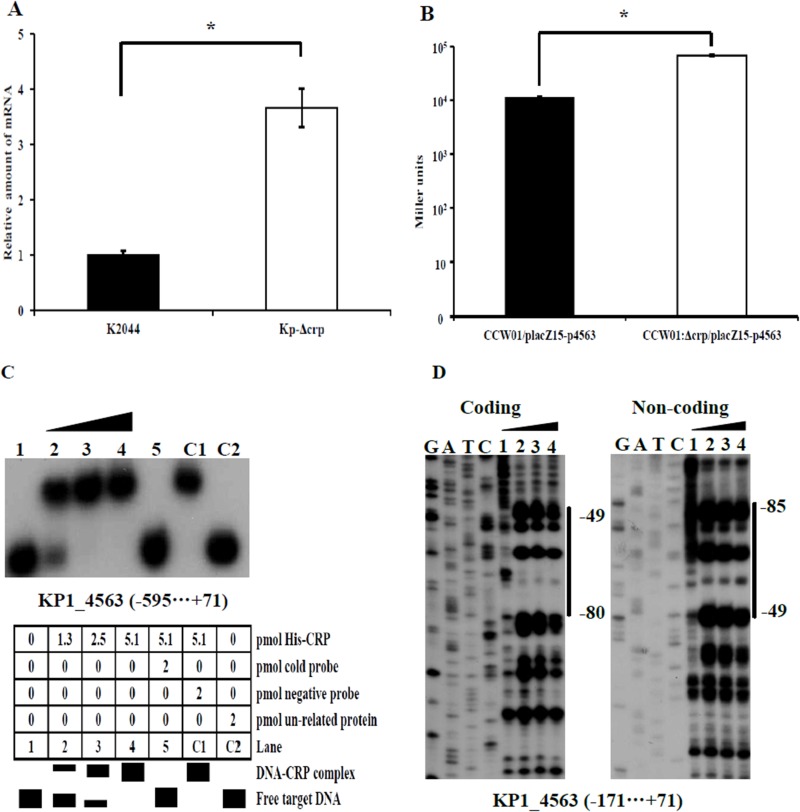
Transcriptional regulation of KP1_4563 by CRP.(A) Quantitative RT-PCR (qRT-PCR). Transcriptional expression of KP1_4563 in WT and Kp-Δcrp. The results are expressed as the percentage of WT expression. Data are presented as the mean of at least three technical replicates (mean ± standard deviation). Statistical significance was analyzed by independent samples t- test. Significant difference is indicated by * for P<0.05. (B) LacZ fusion assay. The putative promoter region of KP1_4563 was cloned into the lacZ transcriptional fusion placZ15 plasmid and then introduced into CCW01 or CCW01Δcrp to determine promoter activity. The results are expressed as β-galactosidase activity (Miller units) in the cellular extracts. Statistical significance was analyzed by independent samples t-test. Significant difference is indicated by * for P<0.05. (C) EMSA. The radioactively labeled putative promoter region of KP1_4563 was incubated with increasing amounts of purified His–CRP protein with cAMP and was then subjected to 4% (w/v) native polyacrylamide gels electrophoresis. The interaction between His–CRP and the promoter region of KP1_4563 formed a DNA–CRP complex, which produced a retarded DNA band with decreased mobility. (D) DNase I footprinting. A labeled coding or non-coding DNA fragment was incubated with increasing amounts of His–CRP (lanes 1, 2, 3, and 4 represent 0, 8.5, 16.9, and 25.4 pmol of purified His–CRP protein, respectively) with cAMP and was then subjected to 8 M urea-6% (w/v) polyacrylamide gels electrophoresis. The footprint region is indicated by vertical bars with positions, and the negative numbers indicate the nucleotide positions upstream of the KP1_4563 gene start codon ATG where the A in the ATG start codon refers to position 1.